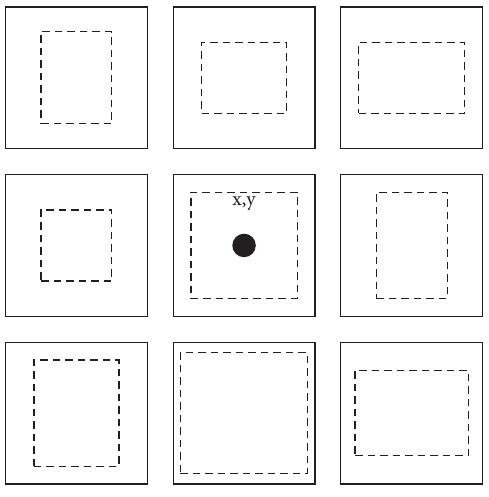
Figure 3: Id assignment strategy.